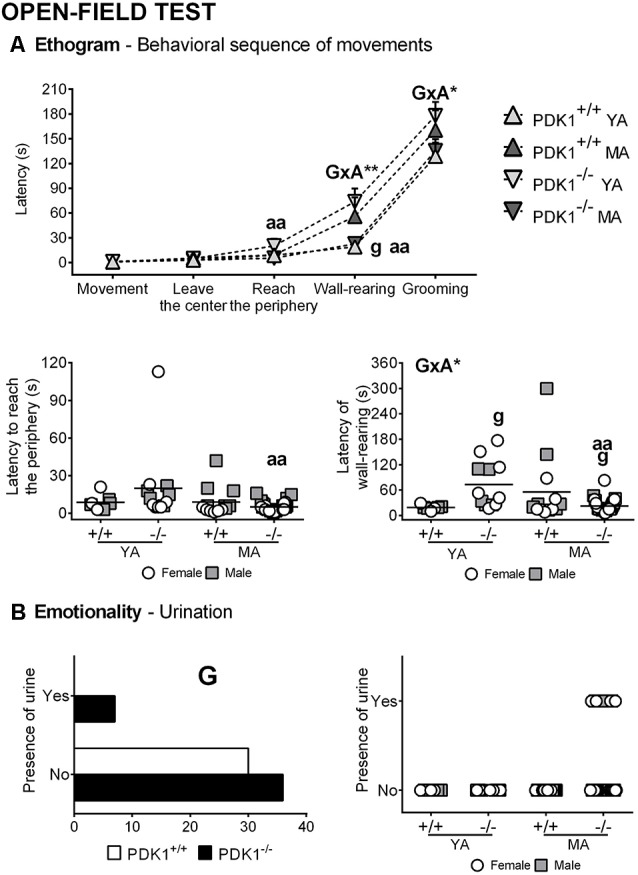
Ethogram and emotionality in the open field test in young adult (YA) and mature age (MA) PDK1−/− and age-matched wild-type (WT; PDK1+/+) mice. Data are expressed as the mean ± SEM or incidence. Bars illustrate the genotype groups, as indicated in the Y-axis. Symbols are used to illustrate the different groups or individual values, as depicted in the legends or abscissae. Factorial analysis: G, genotype effect; A, age effect, *P < 0.05, **P < 0.01. Post hoc test: genotype (g), gP < 0.05 vs. the corresponding WT (PDK1+/+) group; age (a), aaP < 0.01 vs. the corresponding YA of the same genotype.